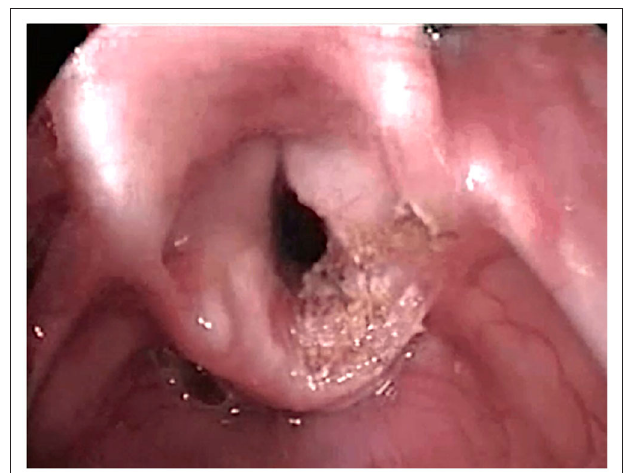
FIGURE 1 | CO 2 Laser right partial